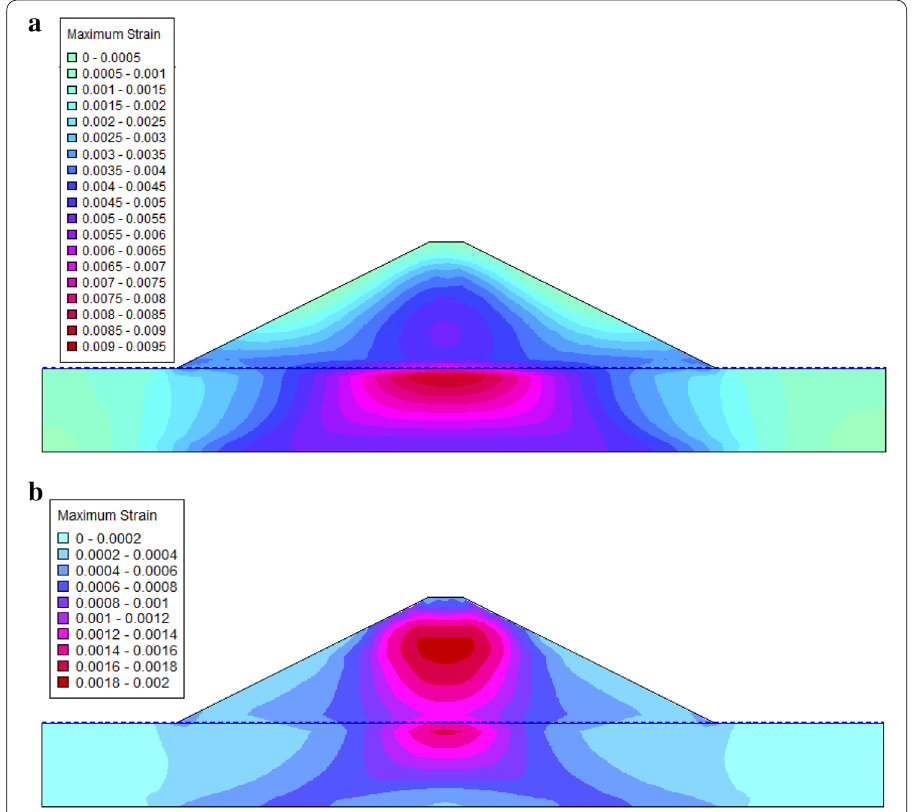
Fig. 10 Maximum strain contours within the earthen dam and its foundation as obtained from a Single-lift technique of simulating construction of earthen dam, b Multiple-lift technique of simulating construction of earthen